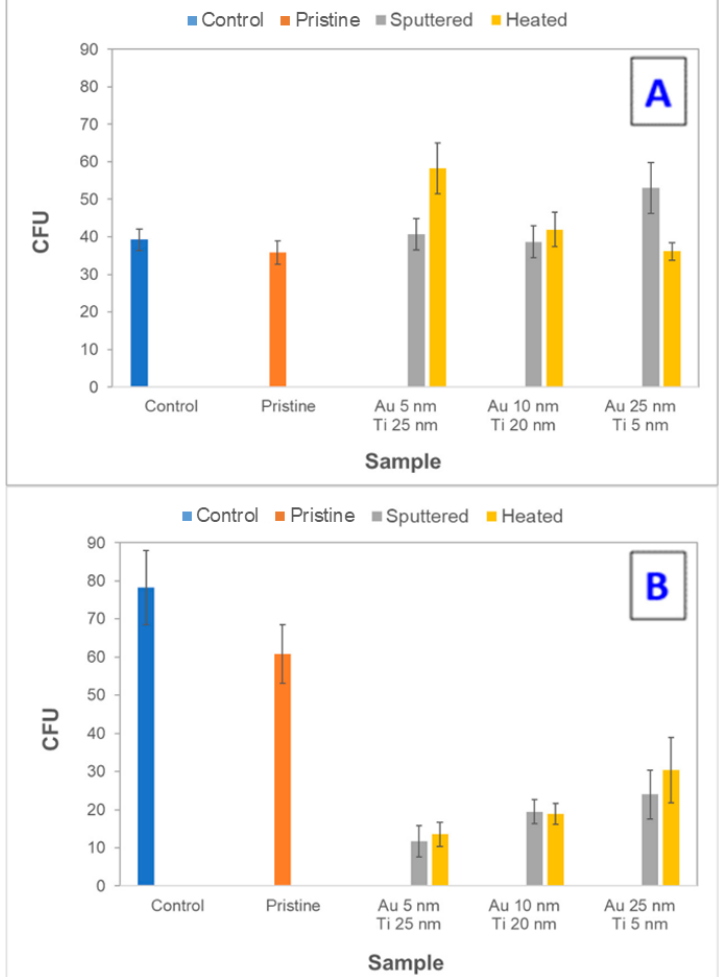
Figure 12. The number of colony-forming units (CFU) of Gram-negative bacterial strain of E. coli incubated with the samples with Ti and Au layers of different thicknesses. ( A ) 2 h, and ( B ) 24 h of contact of the bacterial suspension with the evaluated samples. The blue column represents the CFU of control (untreated bacteria), the orange column represents the CFU of bacteria incubated with a pristine sample, the grey, and yellow columns represent the CFU of bacteria incubated with Ti and Au layers (various thickness), respectively.